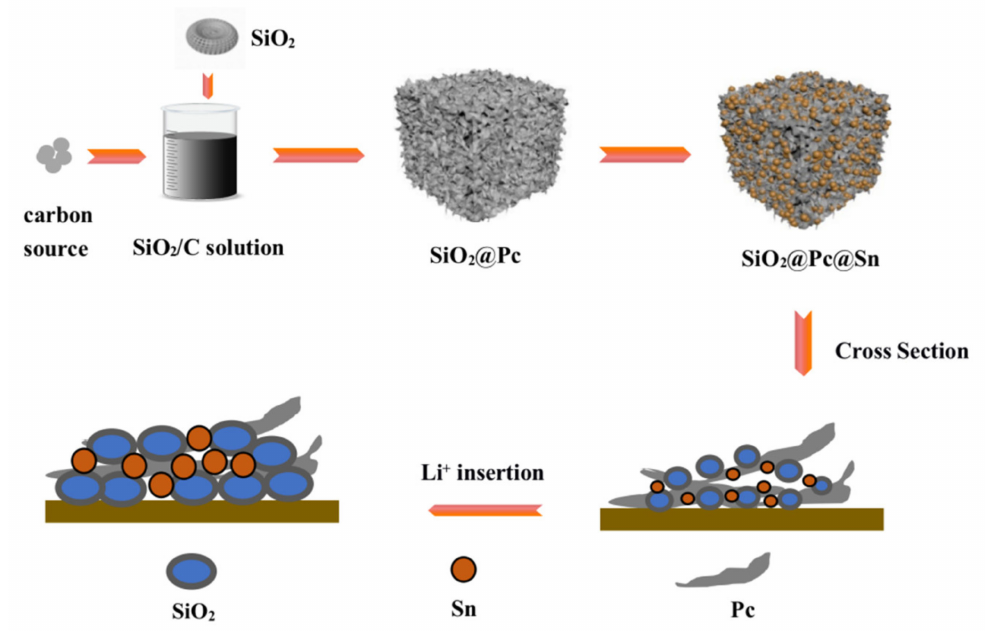
Figure 1. Schematic diagram of the synthesize process of silicon oxide@Pourous Carbon@Tin (SiO 2 @Pc@Sn)